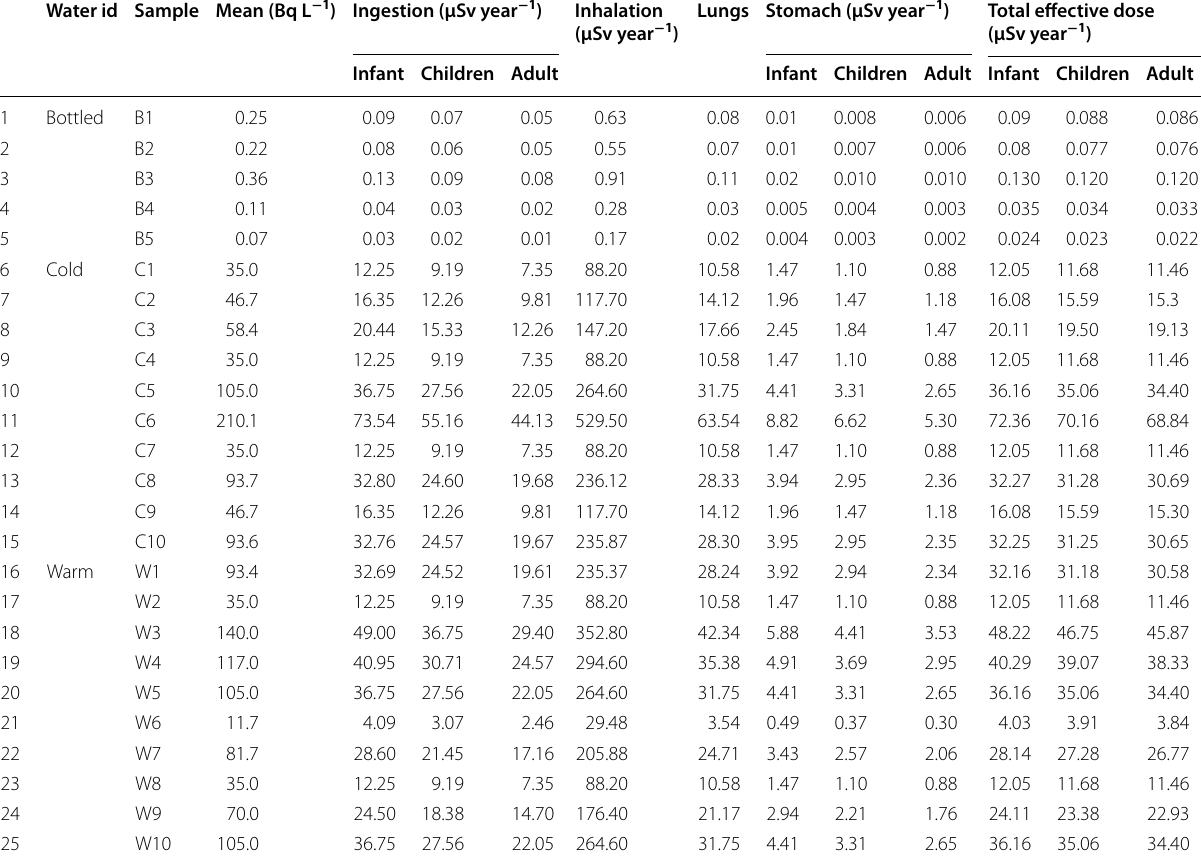
Table 2 Annual effective dose rate contribution to lungs and